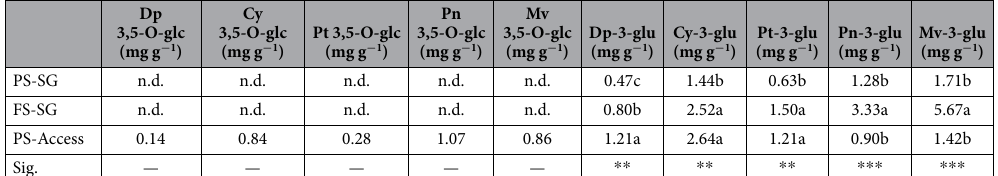
Sig. Table 6. Anthocyanin profile at harvest in berry skins of SG (susceptible clone R10) and accession 72-096 (resistant). PF = partially sprayed. FS = fully sprayed. Data expressed as mg of malvidin-3-O-glucoside equivalent per g of skin dry weight. Abbreviations: Dp: delphinidin, Cy: cyanidin, Pt: petunidin, Pn: peonidin, Mv: malvidin, glc: glucoside, n.d.: not detected. ** and *** denote significant differences between treatments at P < 0.01 and 0.001 according to within column mean separation performed with SNK test and showed by small letters. ns = not significant.